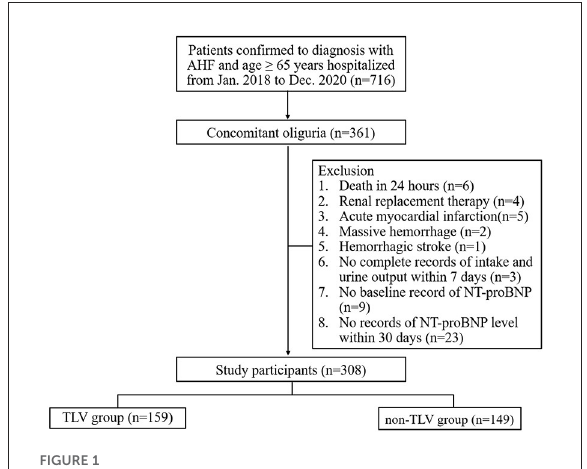
FIGURE1 Flow chart of patient enrollment in this study. NT-proBNP, N-terminal pro-B-type natriuretic peptide.